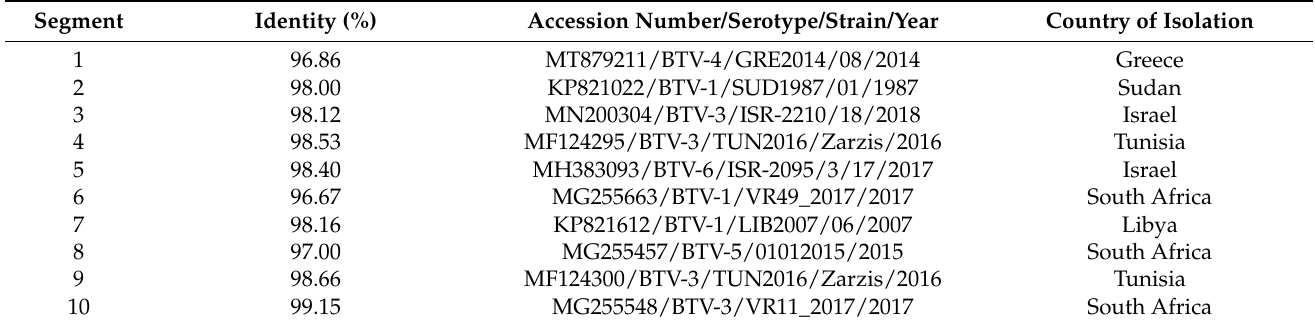
Table 4. BLAST analysis of Israeli BTV-1 ISR-2050/19 isolate with global BTV